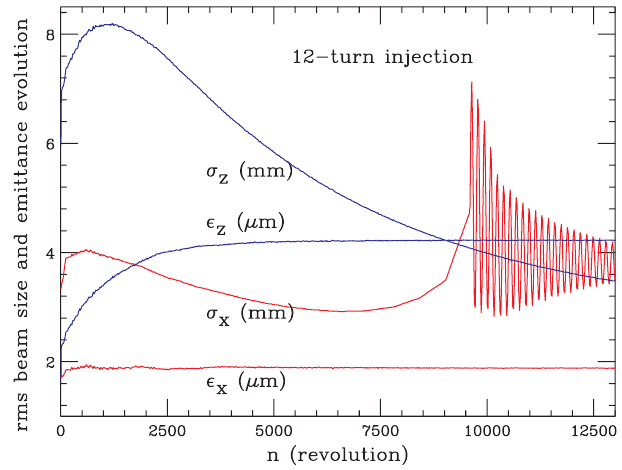
introduced.FIG. 35. (Color) The emittance evolution for a beam with 12- turn injection for the case with random dipole field error (red), and without the dipole field error (blue). The random dipole field error has an amplitude of 2 : 0 (cid:2) 10 (cid:1) 5 rad and 7 : 5 (cid:2) 10 (cid:1) 5 rad for the horizontal and vertical planes,